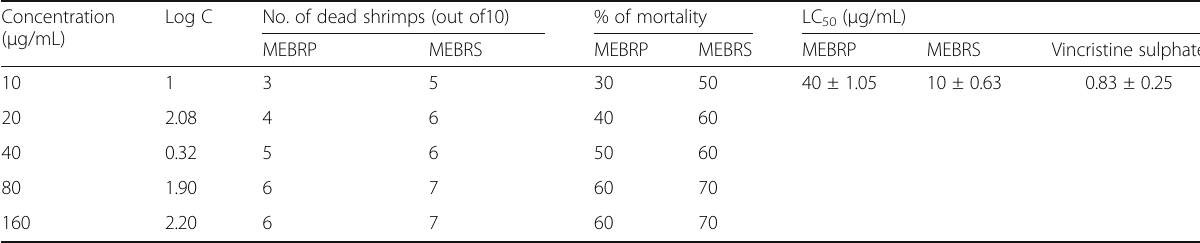
Values are means ± S.E.M. (standard error means) of three independent experiments. MEBRP Methanol Extract of Baccaurea ramiflora pulp , MERBS Methanol Extract of Baccaurea ramiflora